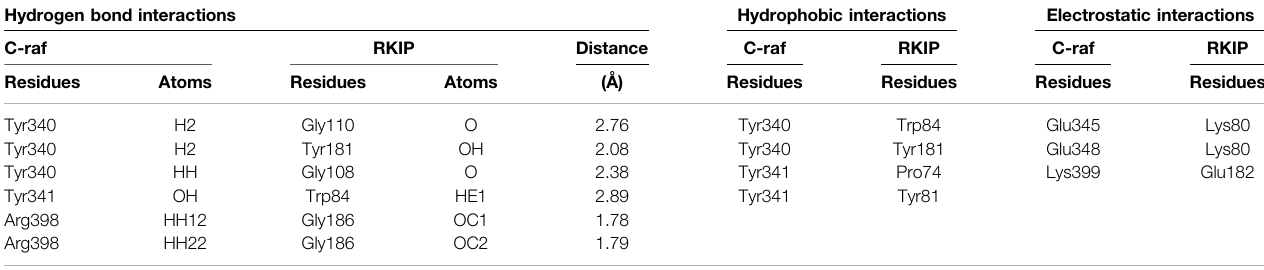
TABLE 4 | MM/PBSA energy for wild-type (WT) and complexes generated through mutations in conserved interface residues of C-Raf and RKIP. Sr. No